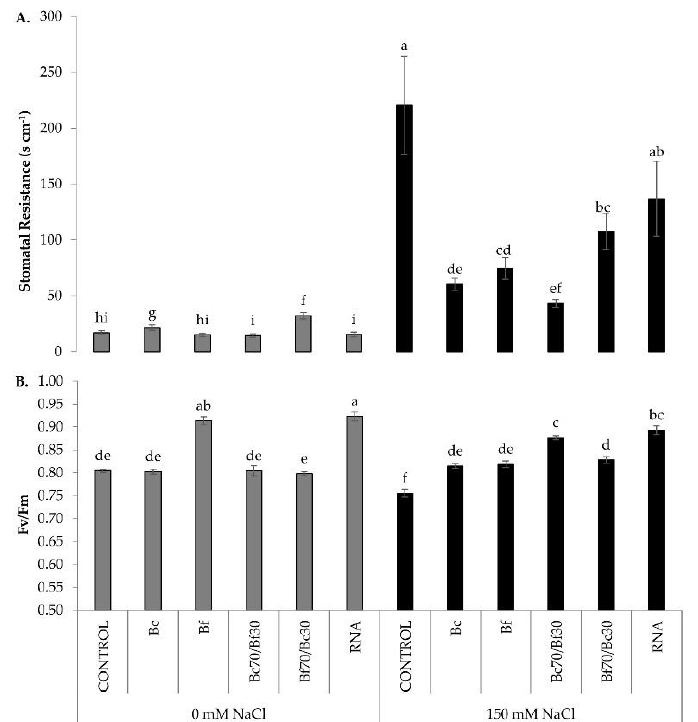
Figure 2. Effect of biostimulant treatments on physiological parameters in control (0 mM) and salt-stressed (150 mM) conditions. ( A ) Stomatal resistance measurement and ( B ) Maximum Fv / Fm photochemical quantum yields of PSII measurement. Data are means ± SE of three replications. Bars with different letters are significantly different ( p < 0.05). Treatment abbreviations are explained in Figure 1.